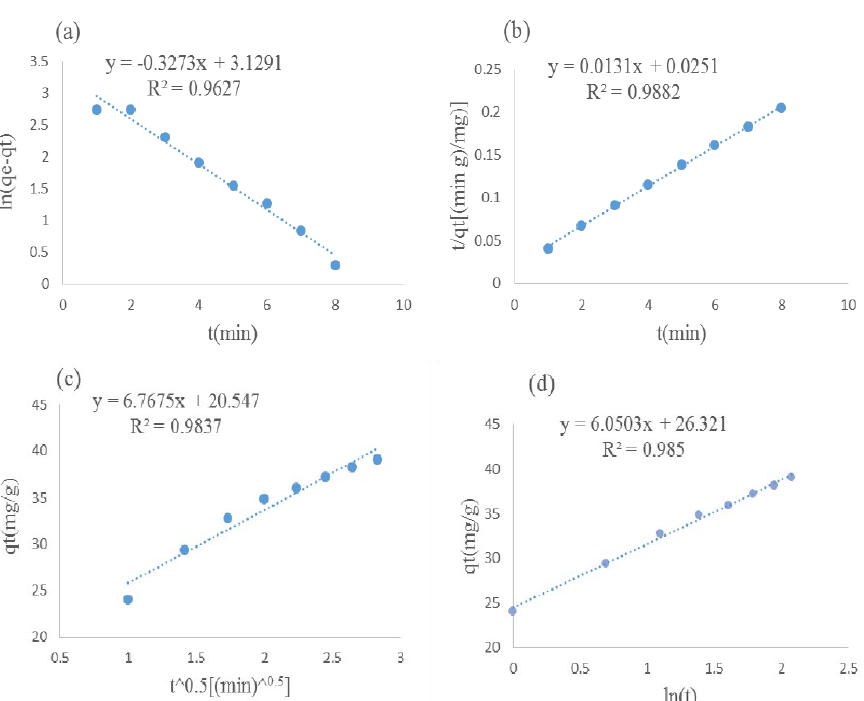
Fig. 5. Plots of kinetic models (a) pseudo first order, (b) pseudo second order, (c) intra particle diffiusion and (c) Elovich model Table 6 Kinetic parameters for adsorption of Pb +2 ions by Fe 3 O 4 @MCM-41-NH 2